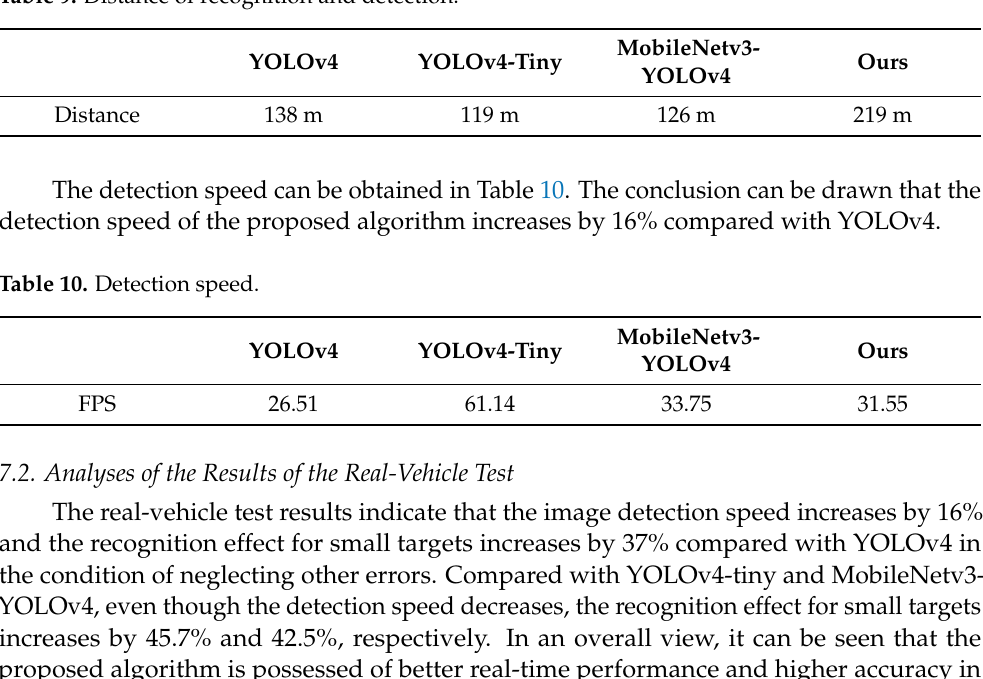
Table 9. Distance of recognition and detection.